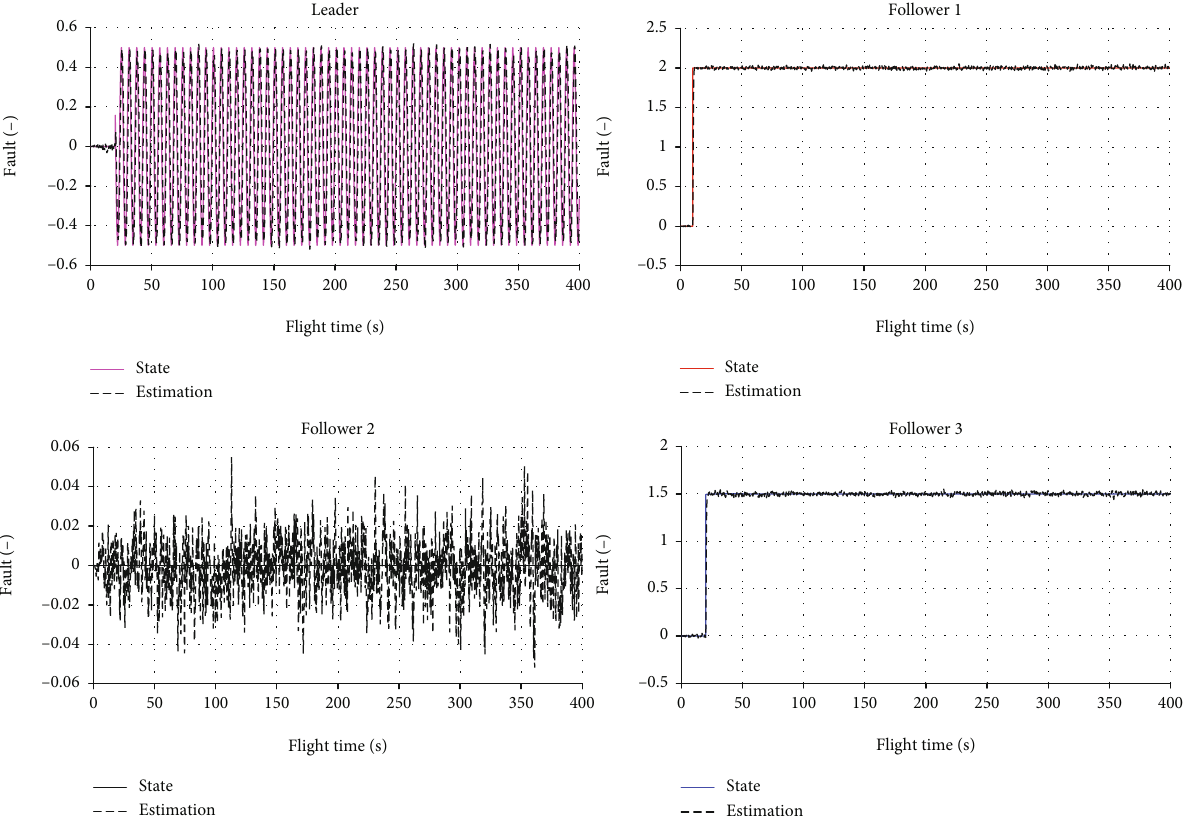
Figure 14: The faults and estimations for the UAV formation (without